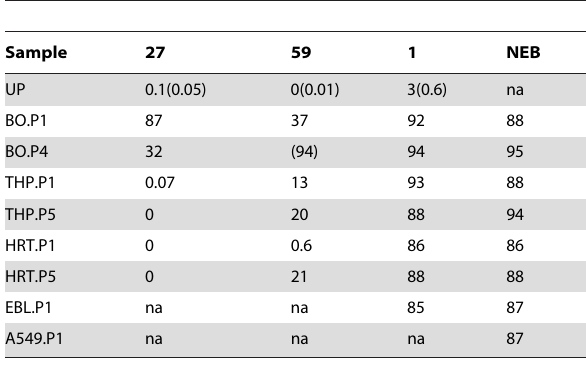
Table 1. Percentage of 454 reads containing the multibasic insert (Illumina data in